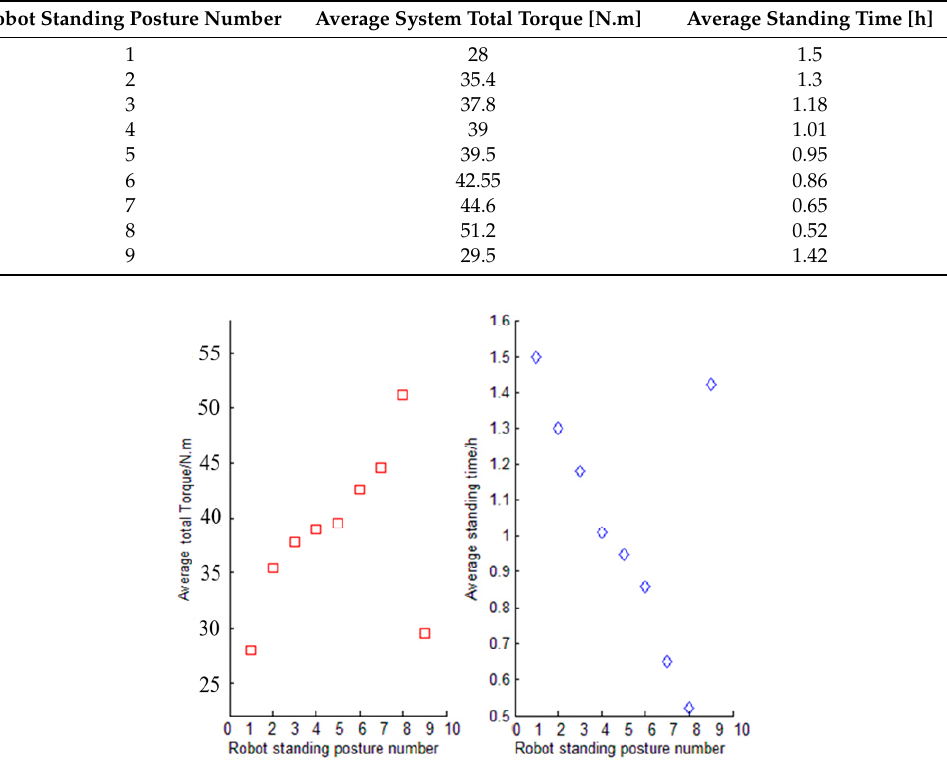
Figure 16. Energy consumption with different robot postures with consideration of energy consumption and maximum step length.